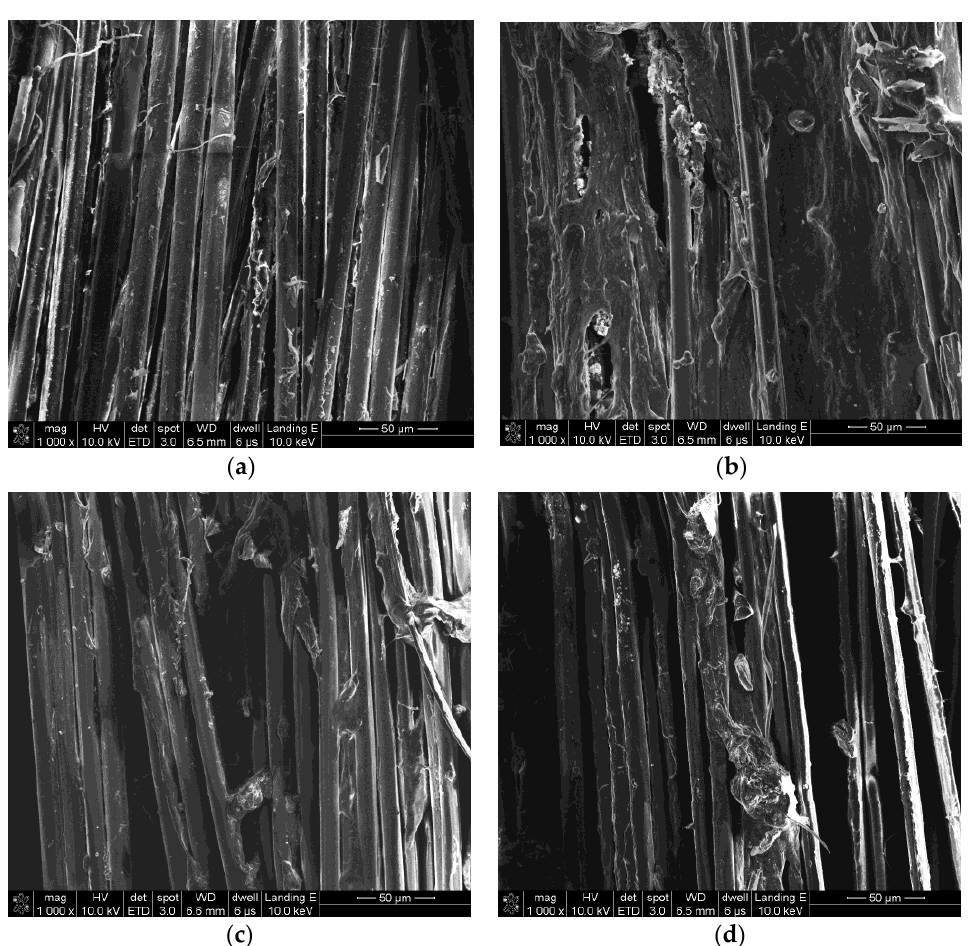
Figure 9. The surface morphologies of PPTA fibers after pull-out: ( a ) A-PPTA; ( b ) PPTA-3; ( c ) PPTA-4; ( d ) PPTA-5.